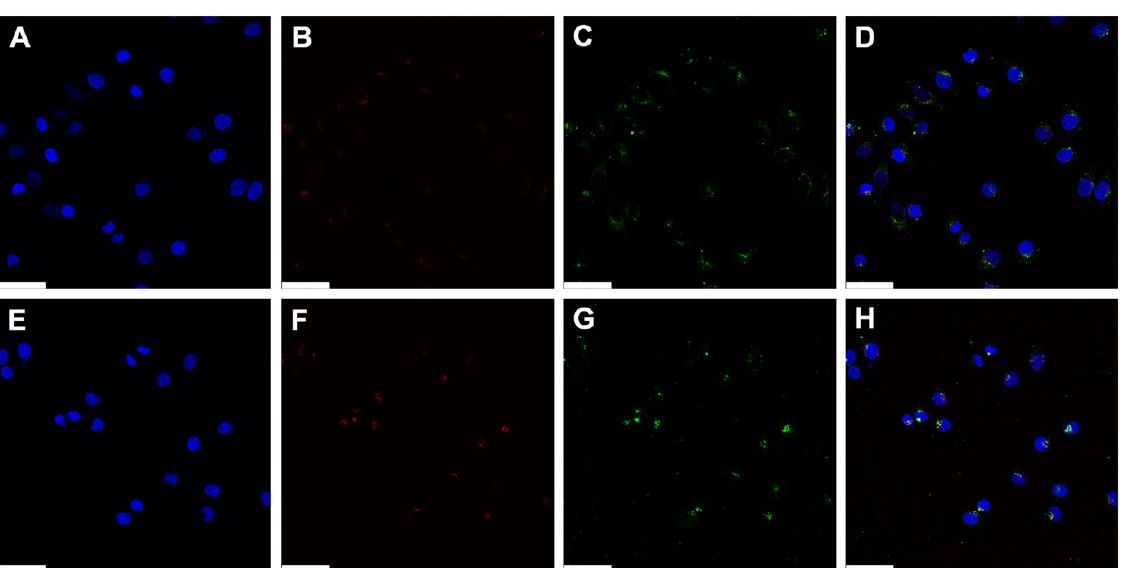
Figure 7. Serum stability test results of HECP2k 10X polyplexes (wr = 50) via luciferase assay. PEI25k polyplexes (wr = 1) were used as control.